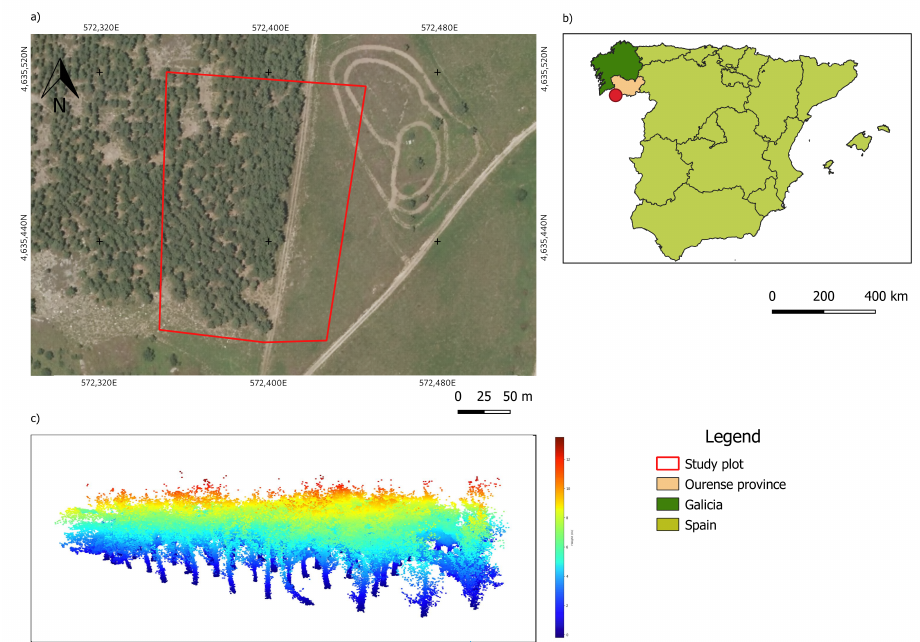
Figure 2. ( a ) Location of the plot in the study area; ( b ) location of the study area in the province of Ourense (Spain); ( c ) collected point cloud.